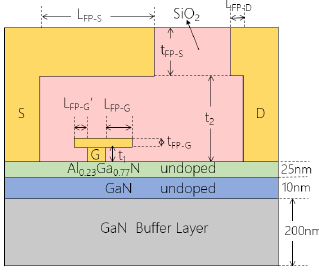
Figure 1. Schematic of HEMT with FP-G, FP-S and FP-D.